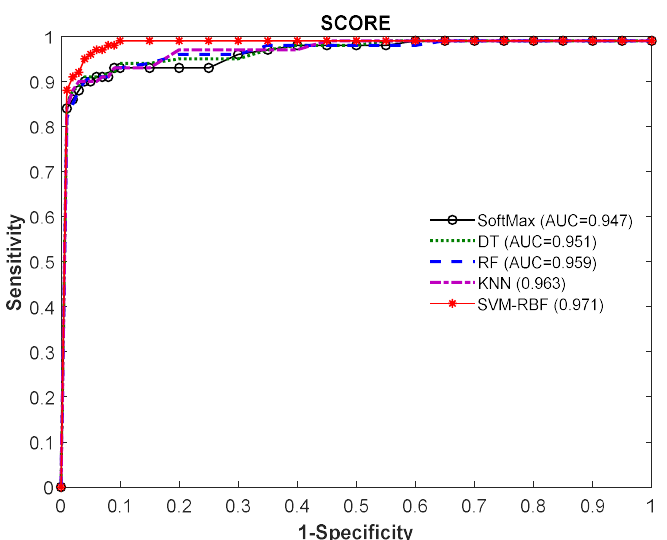
Figure 12. ROC curve attained for VGG19 with DF + HCF.